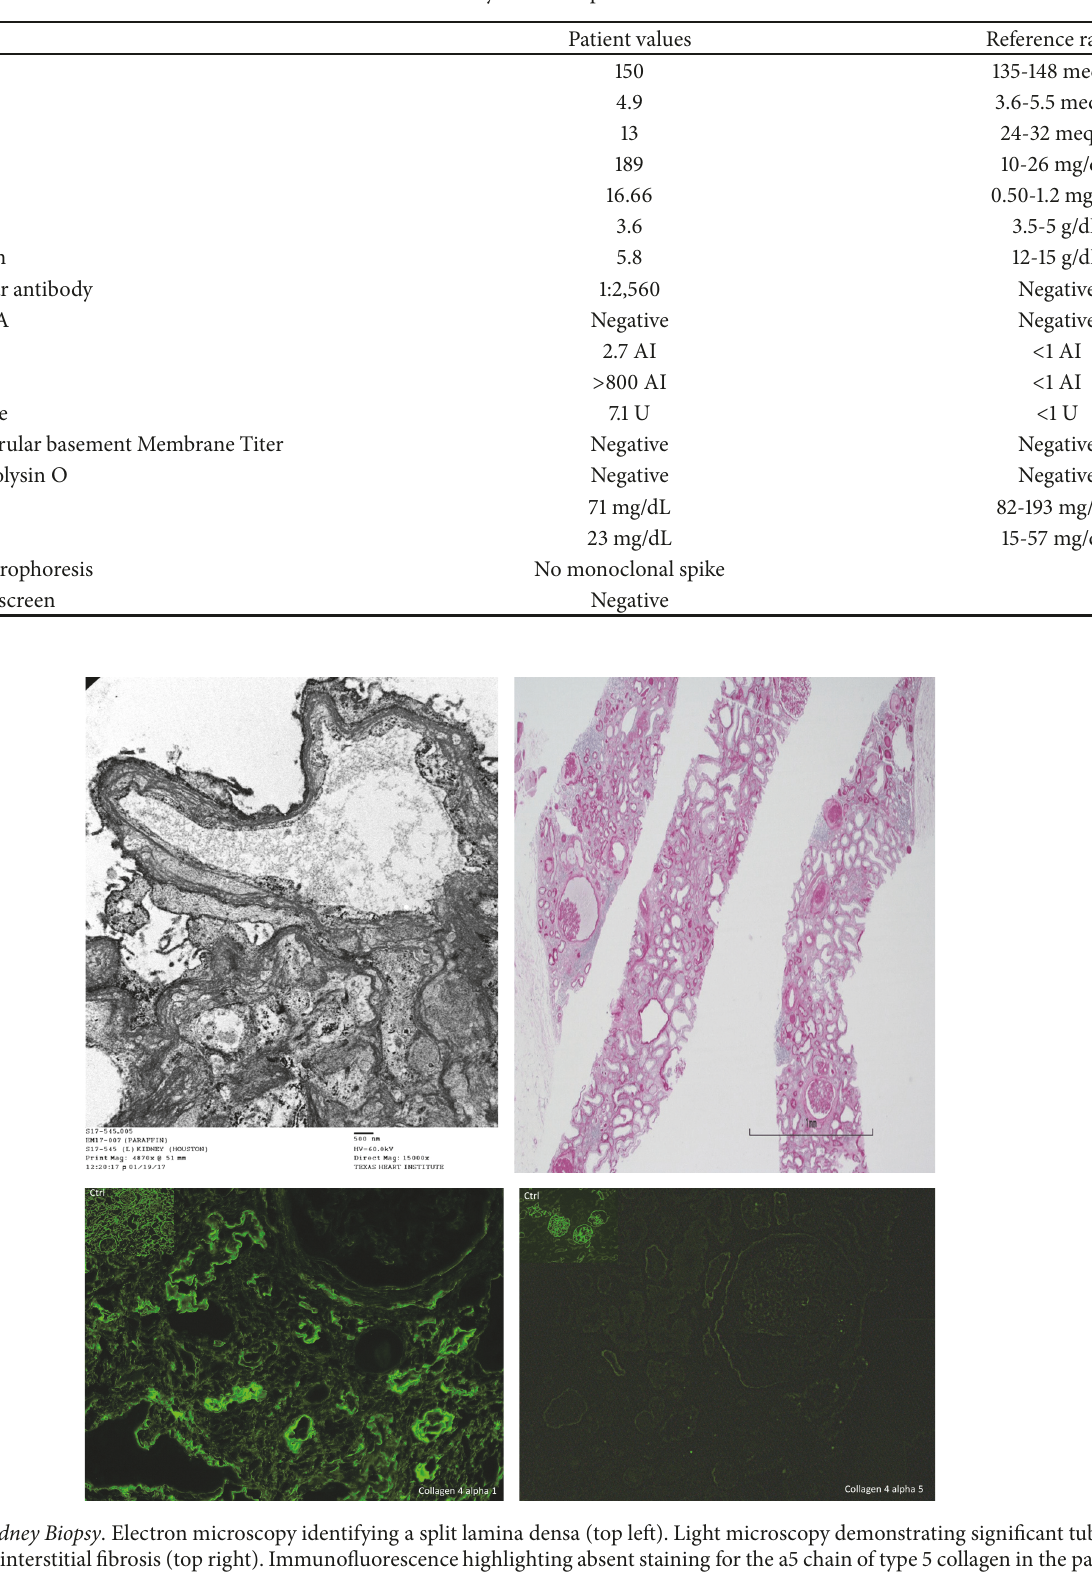
Table 1: Laboratory values on presentation.